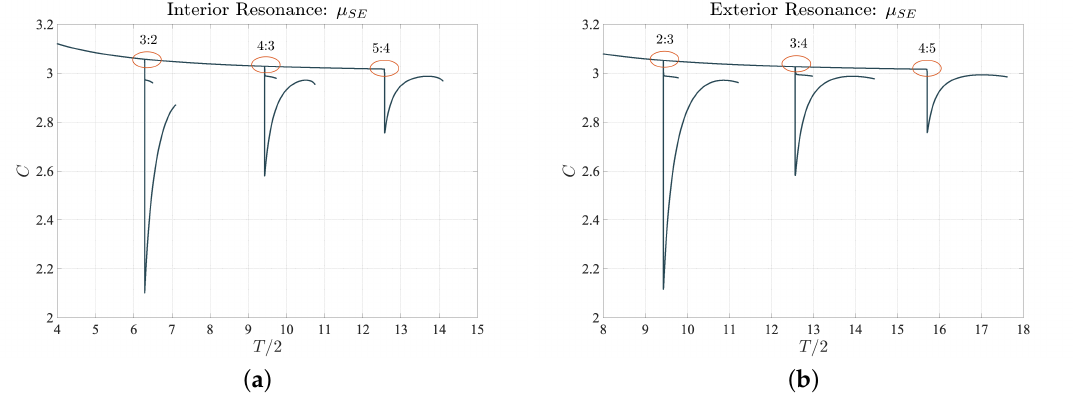
Figure 4. Characteristic curves of the circular families and the first-order resonant periodic families in the CRTBP model of the Sun–Earth system ( µ SE ). ( a ): Interior circular family and the interior